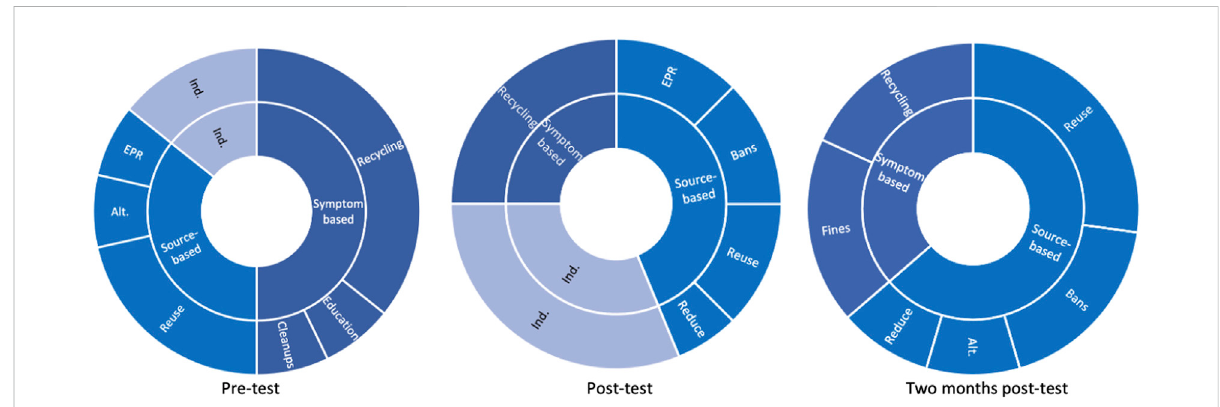
FIGURE 8 Stakeholder perceptions of policies in the United States, pre-test ( n = 14), post-test ( n = 16), 2 months post-test ( n = 14). Alt. = Alternatives to plastic. Ind. = Indeterminate or